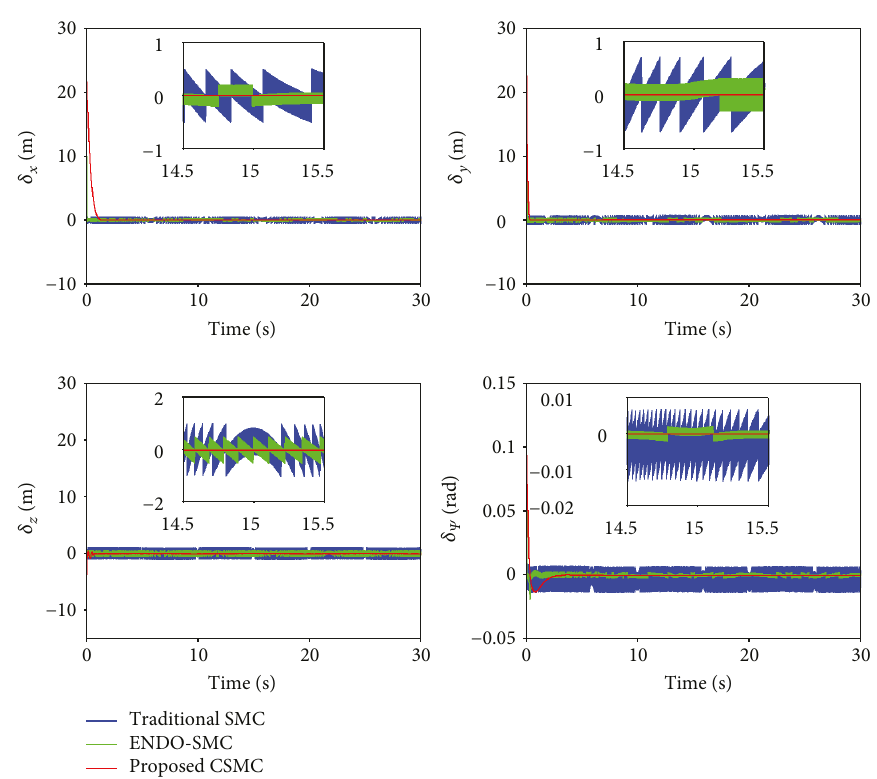
Figure 6: The response curves of sliding surfaces of